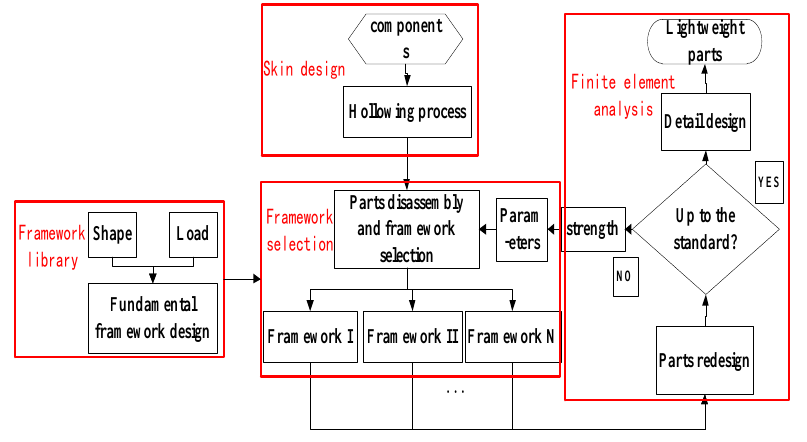
Figure 5. Flow chart of lightweight redesign method.